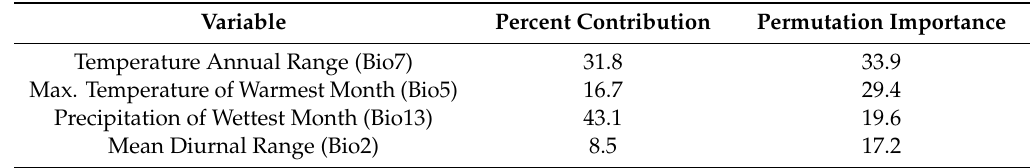
Table 4. Model 2b covariates included in the SDM of Ae. albopictus excluding VZL data, in order of highest to lowest permutation importance.